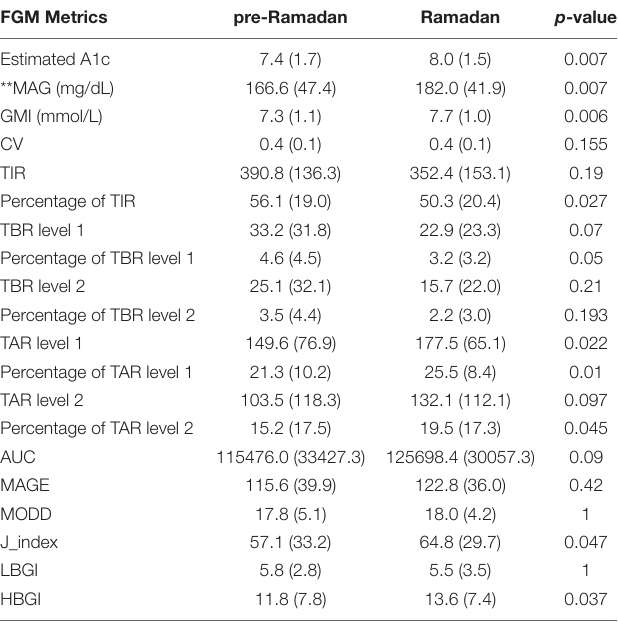
TABLE 2 | Comparison of FGM metrics between *pre-Ramadan and Ramadan during lockdown.